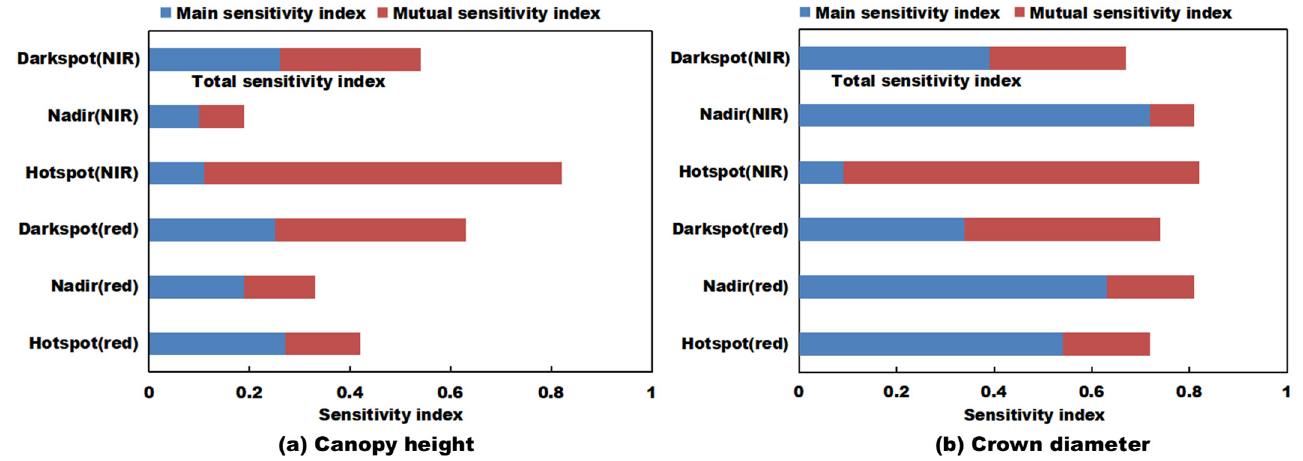
Figure 3. Sensitivity analysis of typical-angle reflectances (i.e., hotspot, nadir, and darkspot) of red and NIR bands on forest biomass-related canopy structure parameters (i.e., canopy height and crown diameter), of which 1 means the most sensitive; ( a ) is the result for canopy height, ( b ) is the result for crown